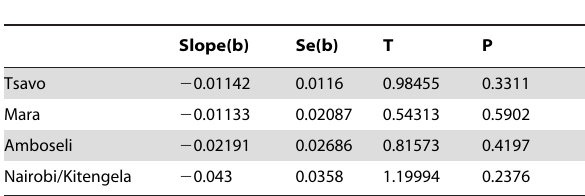
Table 3. The magnitudes and significance of interactions between yearly changes within parks and adjacent